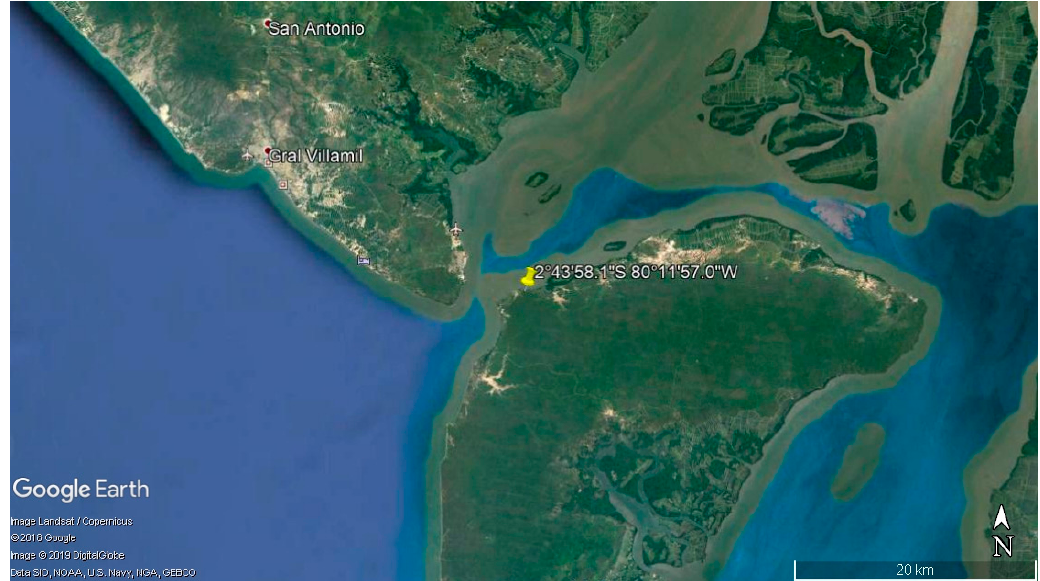
Figure 3. Location of the anemometric tower on Puná island. Source: [3].